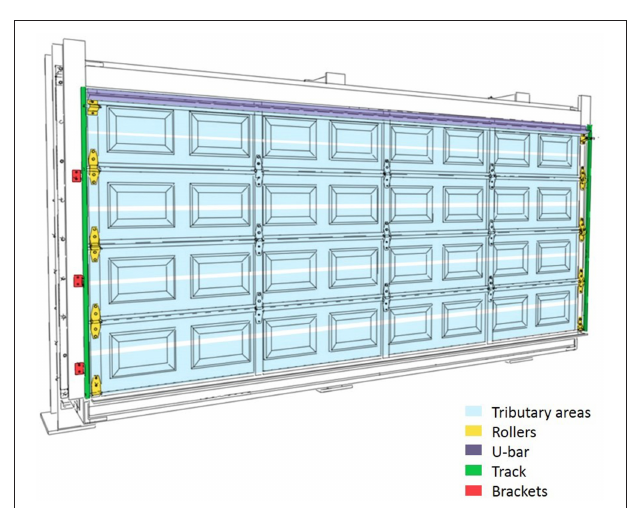
FIGURE 2 | Diagram of mounted garage door, highlighting tributary areas, and load transfer